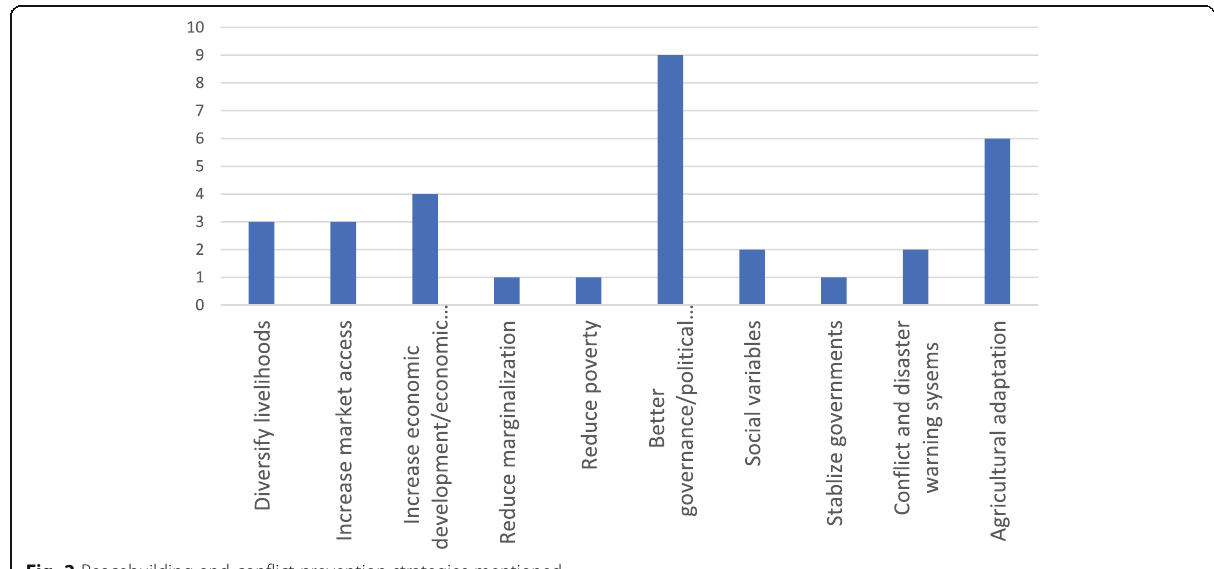
Fig. 2 Peacebuilding and conflict prevention strategies